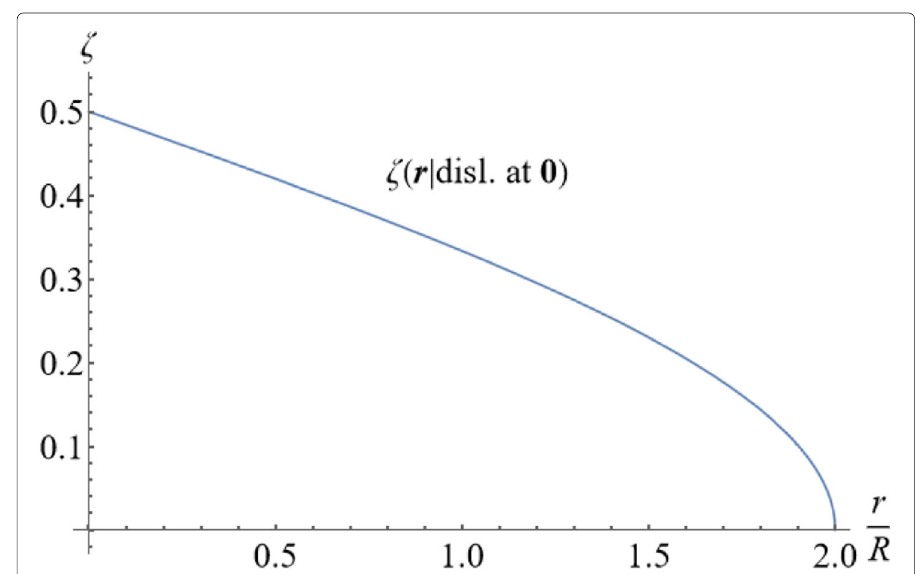
Fig. 2 The probability of points to be enclosed by a random circle of radius R through the origin, ζ( r | disl. at 0 ) , as a function of distance